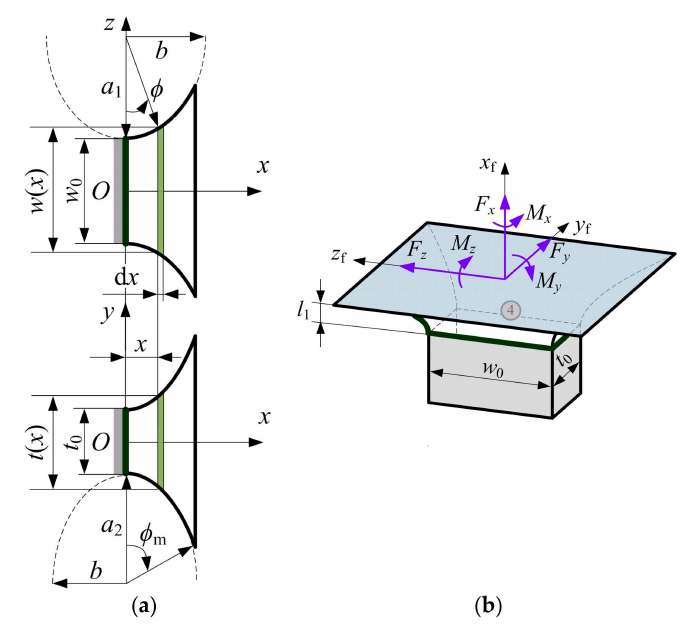
Figure 7. Right half-segment two-axis elliptical-arc flexure hinge: ( a ) Geometric parameters defining two non-identical symmetric elliptical-arc profiles; ( b ) Three-dimensional